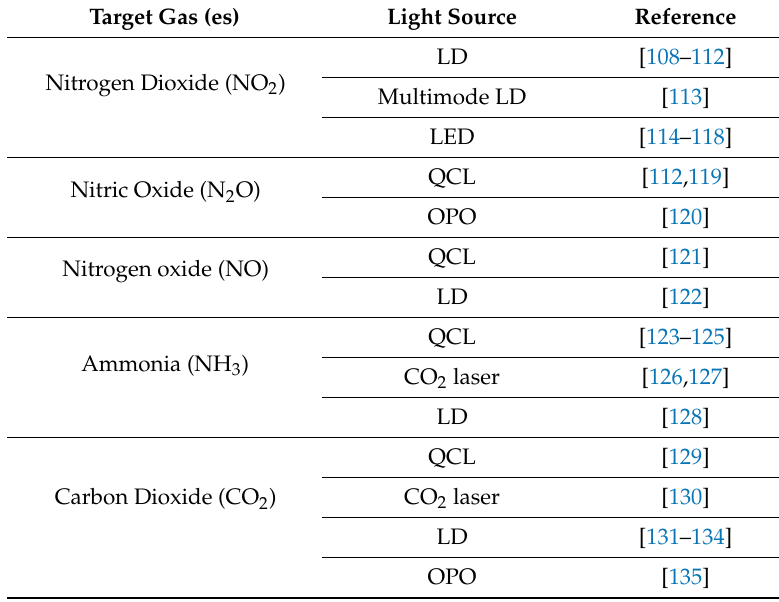
Table 2. An excerpt of past acoustic resonator-enhanced photoacoustic demonstrations. All references have used a microphone as sound transducer. Abbreviations LD: Laser Diode, QCL: Quantum Cascade Laser, OPO: Optical Parametric Oscillator, LED: Light-Emitting